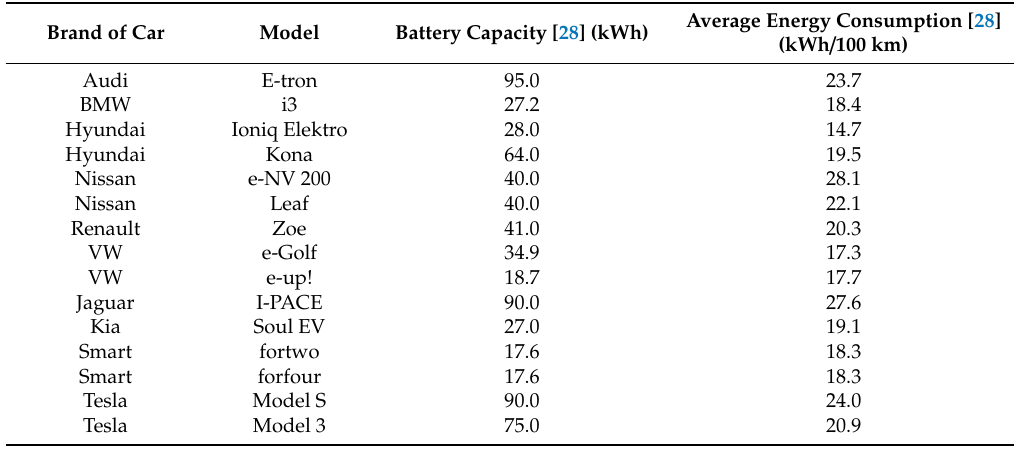
Table A2. Overview of the 15 di ff erent considered EV